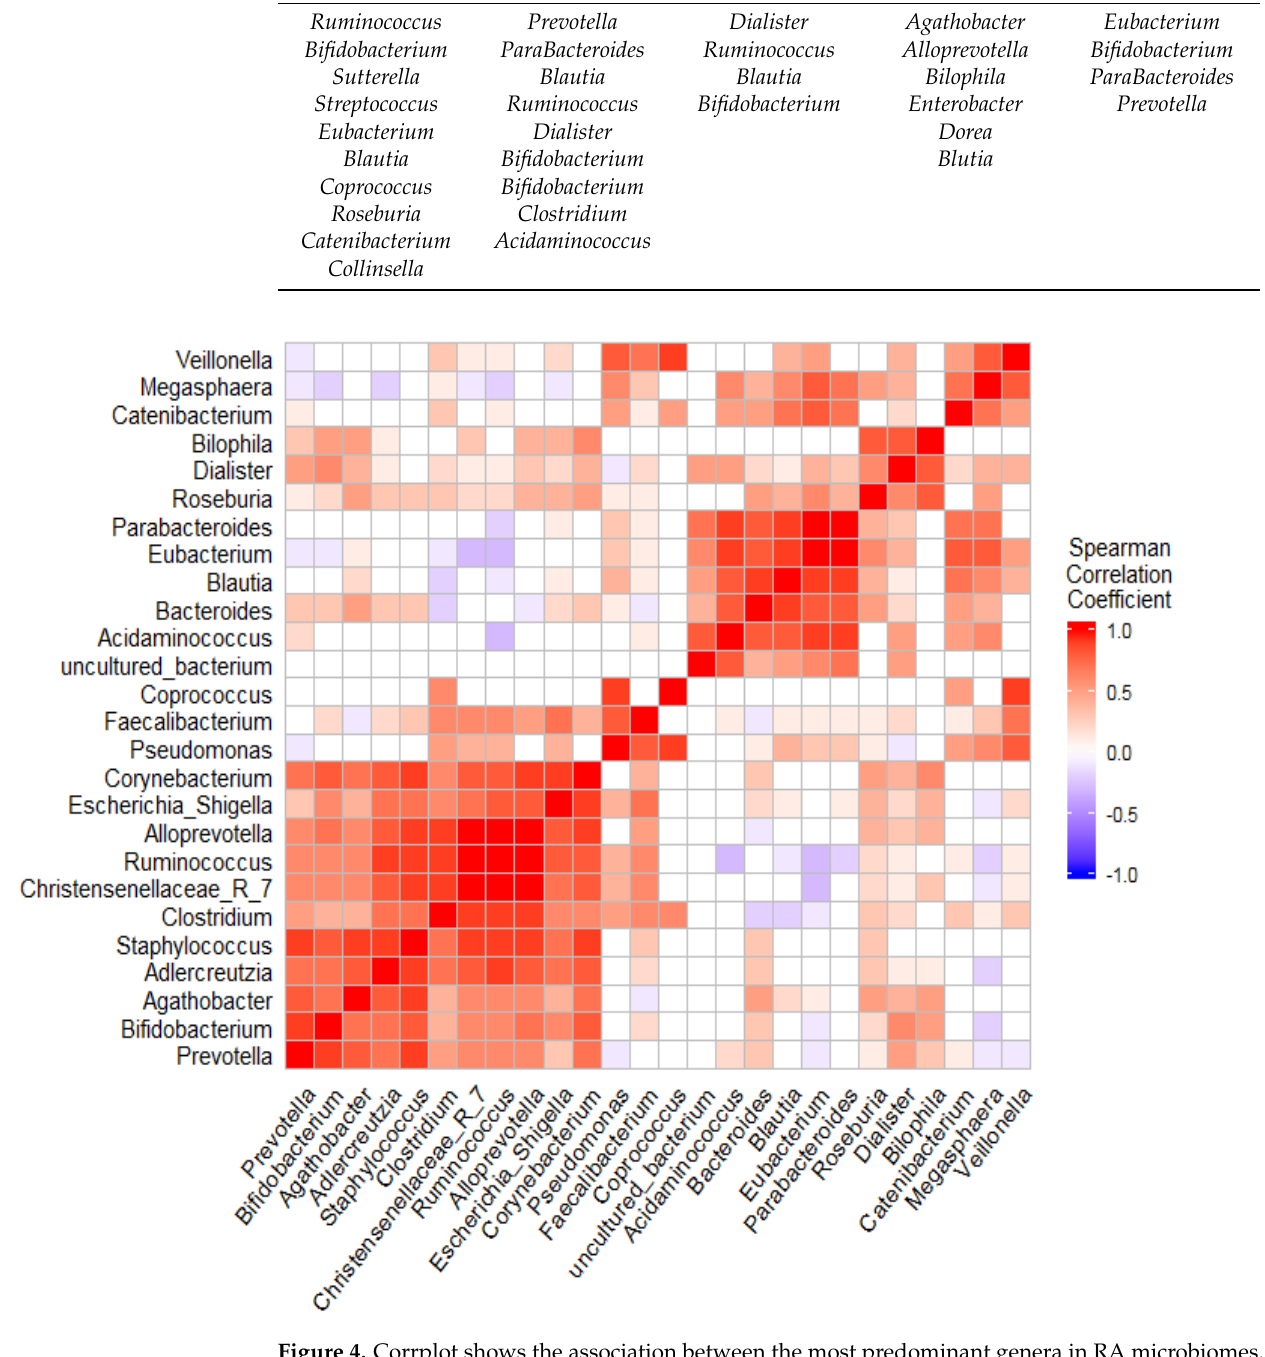
Figure 4. Corrplot shows the association between the most predominant genera in RA microbiomes. Spearman correlation coefficient was used to define the correlation between the dominant genera (r ≥ ±0.6, p ≤ 0.01). Table 2. Enterotypes detected in the gut microbiome of healthy participants and RA patients.